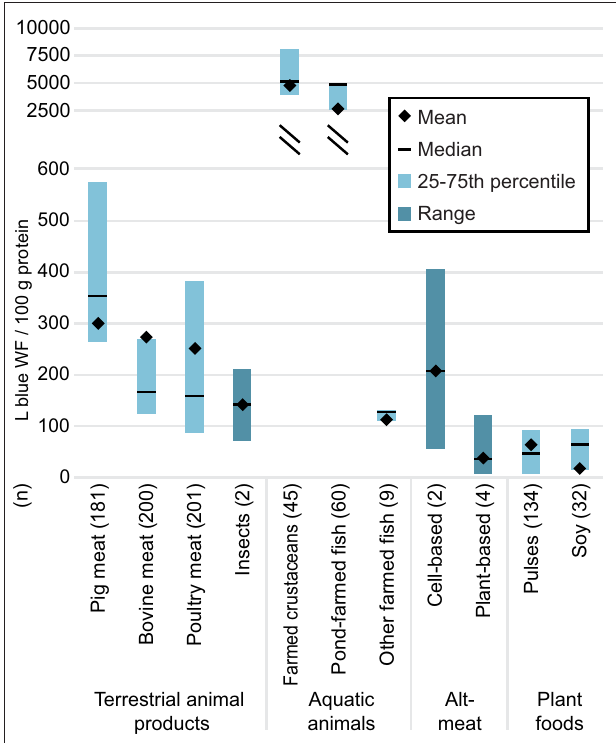
FIGURE 5 | Blue water footprints per 100g protein. For cell-based meat, plant-based substitutes, and insects, the mean and median were calculated using the mean value from each individual study ( n ) to avoid over-representing results from studies that included more products than other studies. The minimum and maximum values of the range were derived from individual product footprints. For data sources and individual product footprints, see Supplementary Data . Data for all other foods came from Kim et al. (2019); for these n represents the number of data points included.